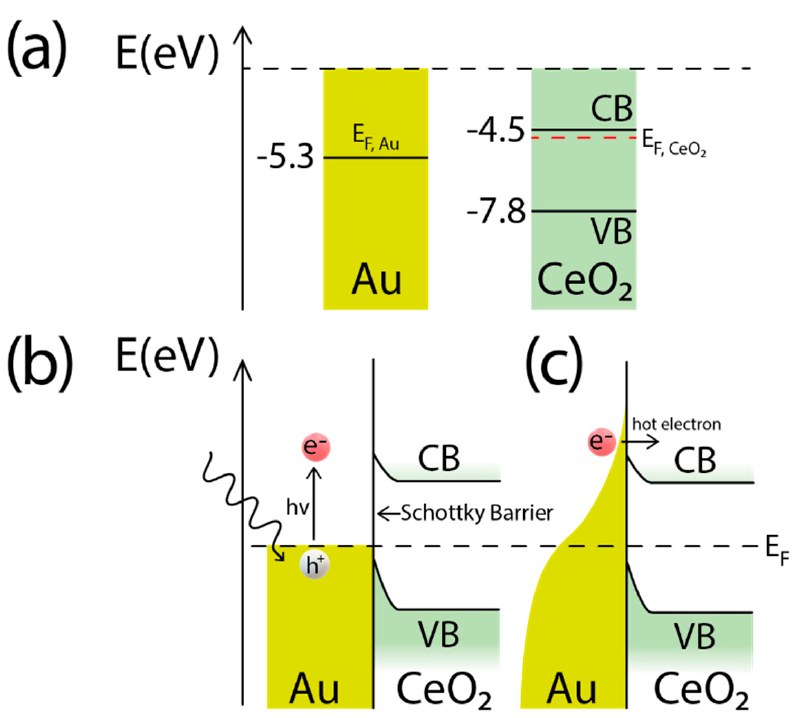
Figure 4. Energy band structure of Au-CeO 2 photocatalysts. ( a ) Energy band levels of Au and CeO 2 respectively; CeO 2 possess a relatively large band gap, needing from UV light to photo-generate charge carriers; ( b ) energy band distribution upon the gold plasmon excitation to ( c ) inject hot electrons into the conduction band of CeO 2 .